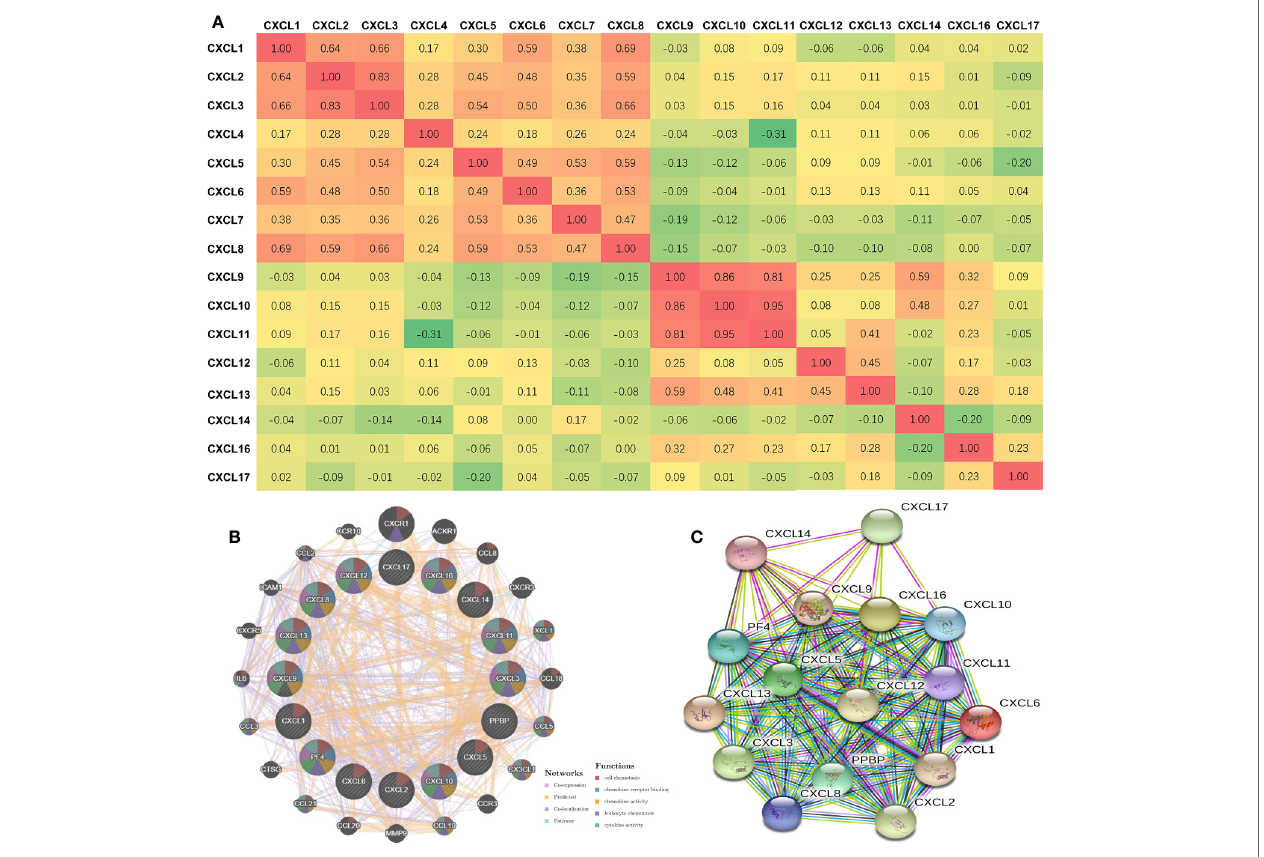
FIGURE 4 | Co-expression and Interaction Analyses of CXCL chemokines at the Gene and Protein Levels in Patients with HNSCC (CBioportal and GeneMANIA and String). (A) Pearson correlation of CXC chemokines members. (B) Gene-gene interaction network among CXC chemokines members in the CBioportal dataset. (C) Protein-protein interaction network among CXC chemokines members in the String